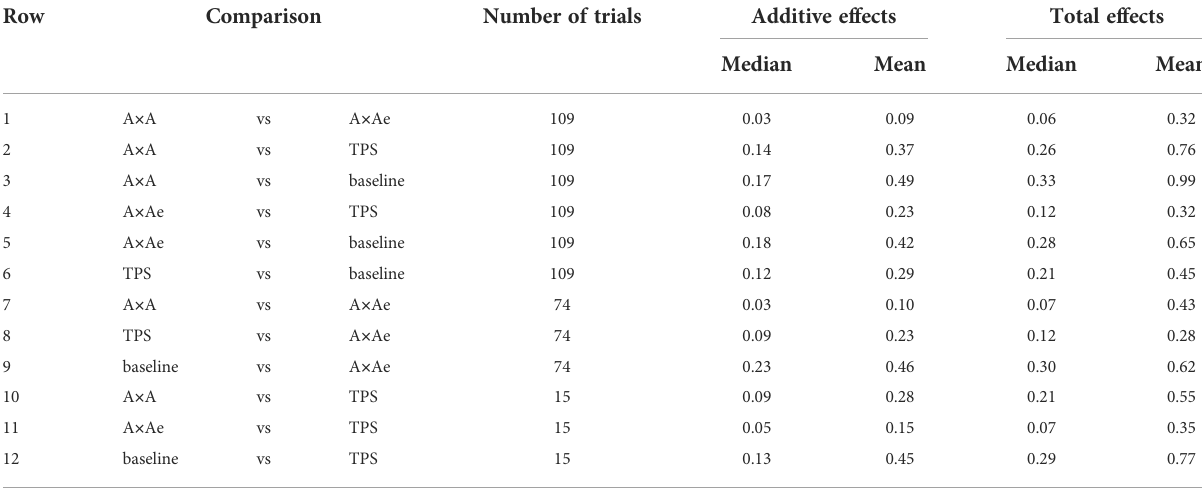
TABLE 4 The median and mean distance measure of Martin (1990) for pairwise comparisons between A × A, A × Ae, TPS and baseline models, for the sets of additive and total genetic effects and for all individuals in the data, rows 1 to 6. Row